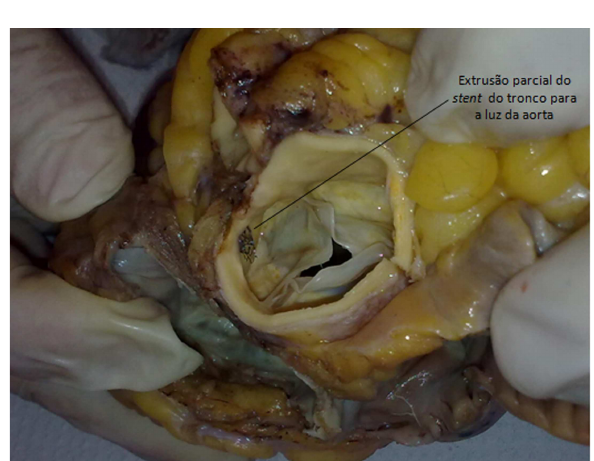
Fig. 3 - Durante o exame anátomo-patológico a artéria circunflexa foi seccionada em terço proximal, por onde foi introduzido um explorador vascular em direção ao tronco de coronária esquerda. O explorador progride livremente até a malha epitelizada do stent, que oclui o óstio da a.